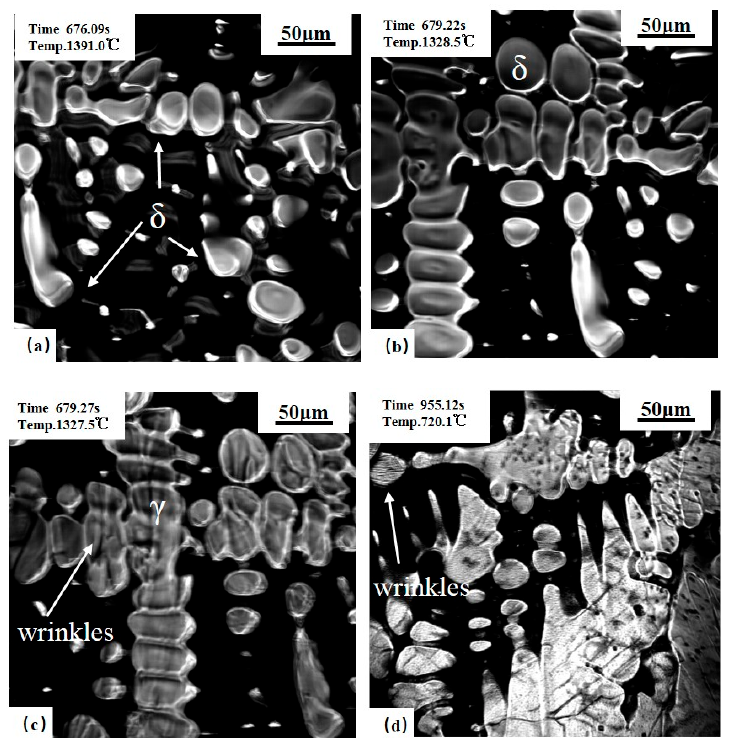
Figure 4. Confocal scanning laser microscope (CSLM) results of the 0.10C% steel. ( a ) δ growth; ( b , c ) before and after δ – γ transformation; ( d ) the wrinkles of low temperature phase transformation.